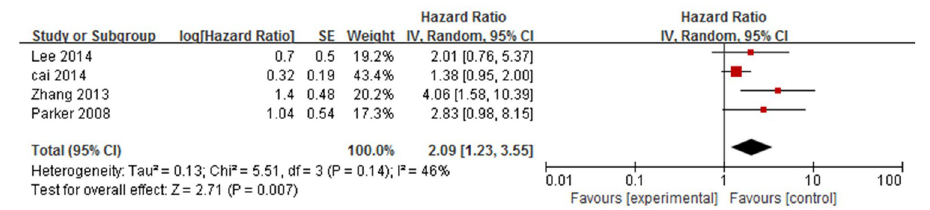
Fig 13. Forest plot of the association between stroke and bullous pemphigoid mortality.